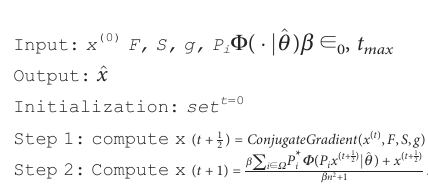
ALGORITHM 1 DAE assisted reconstruction